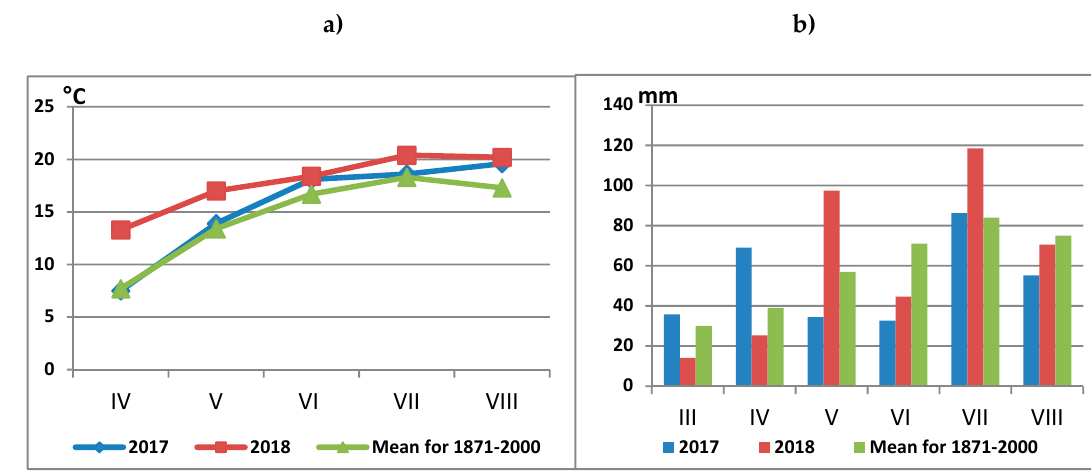
Figure 1. Course of weather conditions during vegetation season of the years 2017–2018. ( a ) Figure1. Courseofweatherconditionsduringvegetationseasonoftheyears2017–2018. ( a )Temperature Temperature ( a ) and ( b ) precipitation. and ( b )